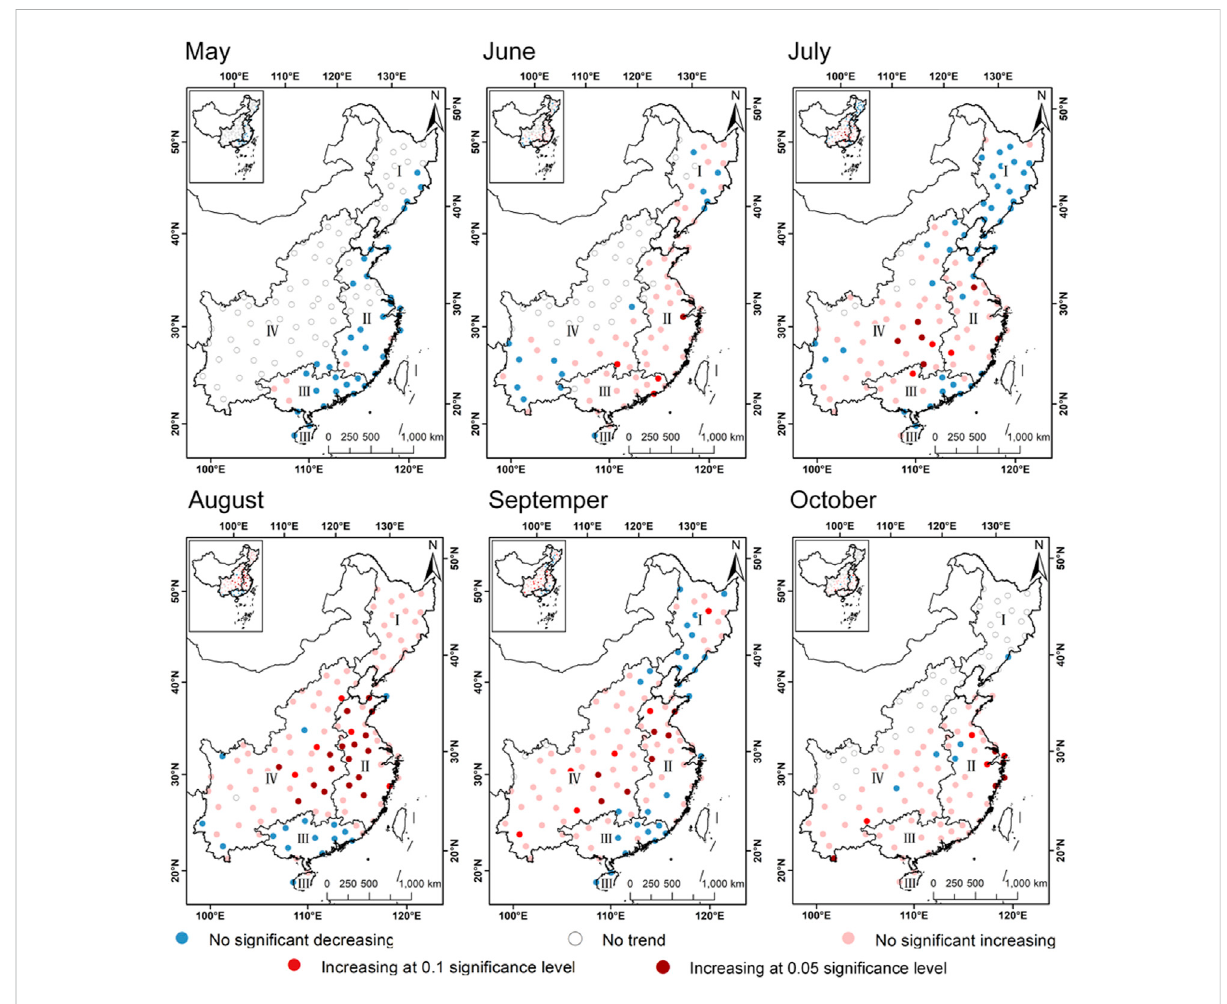
FIGURE 9 Spatial distribution of the PWMK test for TCP over China from May to